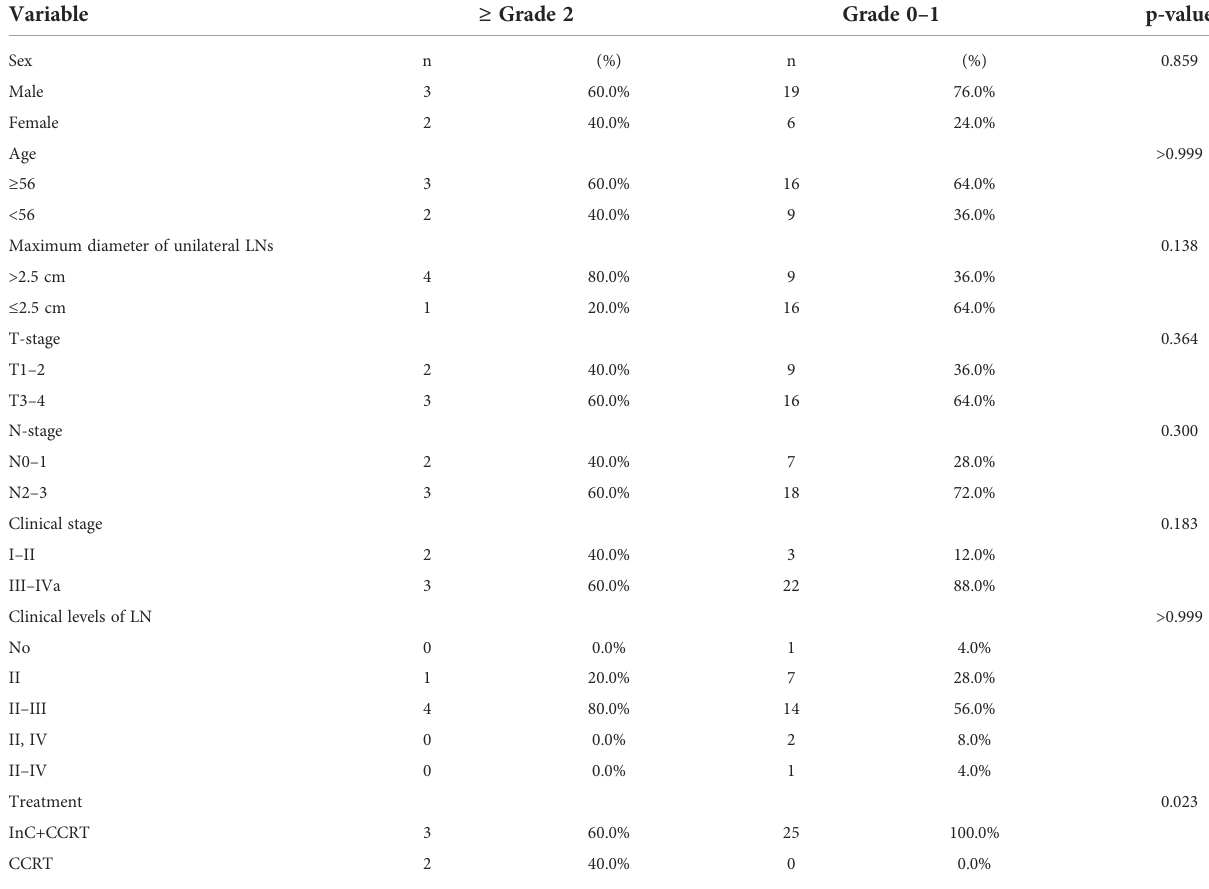
TABLE 3 Association between xerostomia and clinical characteristics.